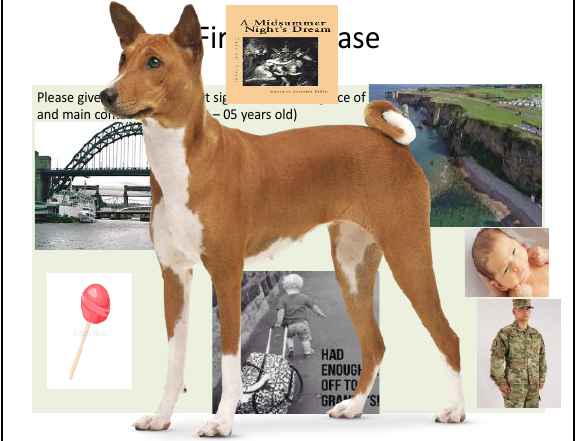
Figure 8. Timeline of Diana’s early childhood.